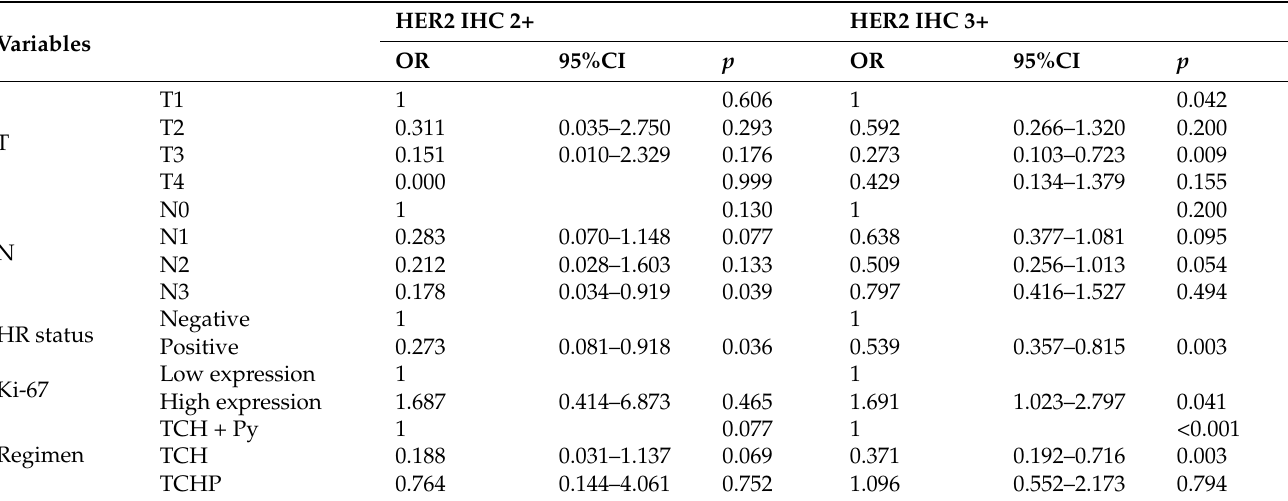
Table 5. Multivariate analyses of factors associated with pCR in subgroup by HER2